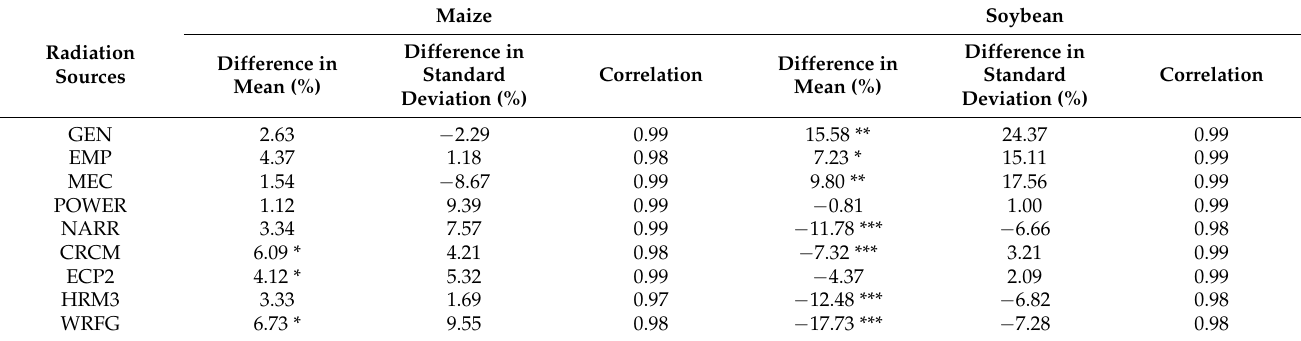
Table 3. Percent difference in the mean and standard deviation of simulated maize and soybean yields using estimated versus observed daily solar radiation as input, and the correlation between the yield time series for the study period. Paired t -tests were used to test for equality of means and F-tests for equality of variances. Asterisks indicate two-tailed probabilities significant at the 90% (*), 95% (**) and 99% (***) probability levels.